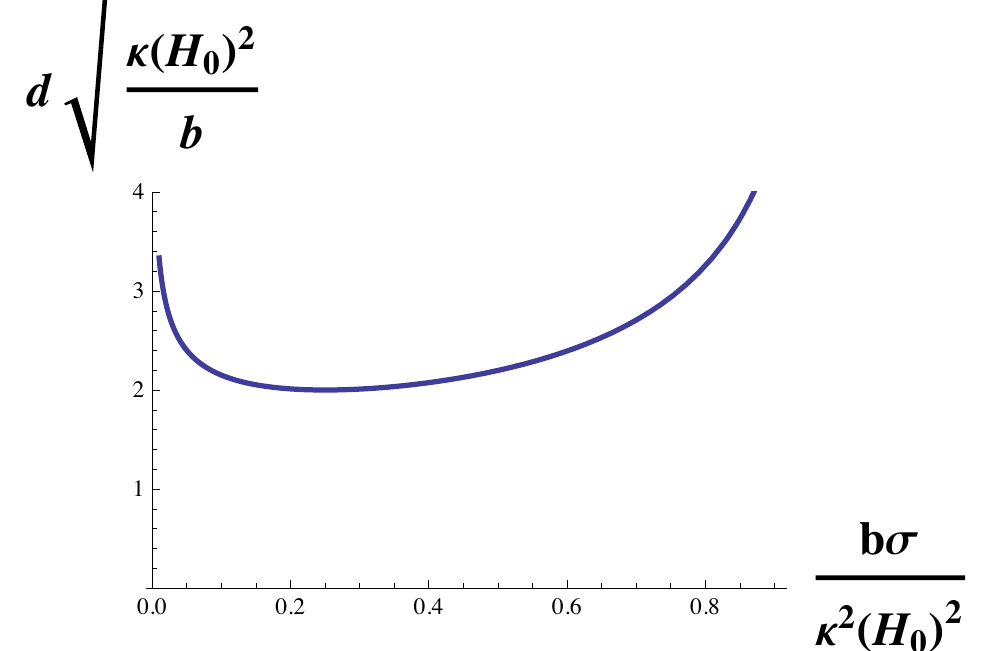
) 1/2 is plotted vs. b σ / κ 2 H 2 0